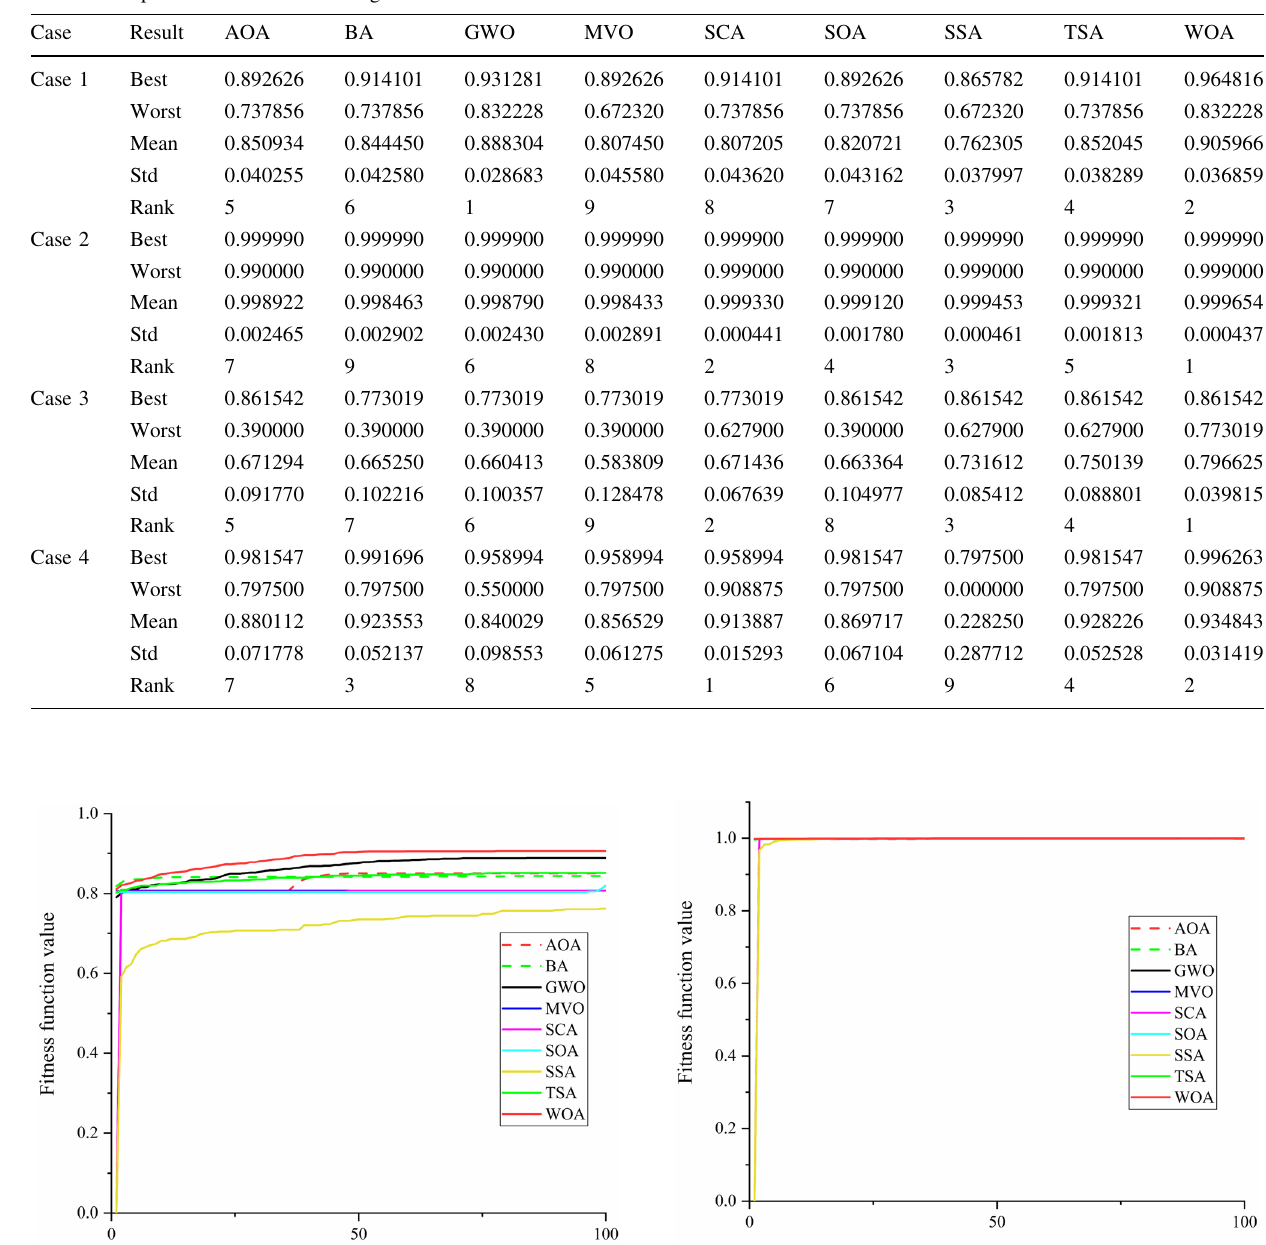
Table 12 Experimental results of all algorithms for WTA